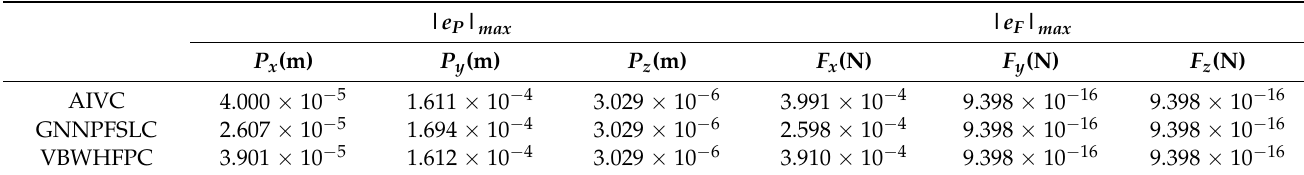
Table 2. Position and force accuracies during the wiping